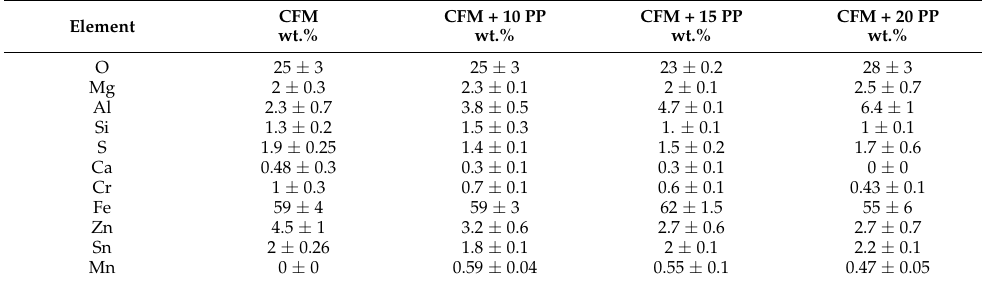
Table 5. Average of point EDXS analysis on the secondary contact plateaus deposited on pins. Element CFM wt.% CFM + 10 PP wt.%